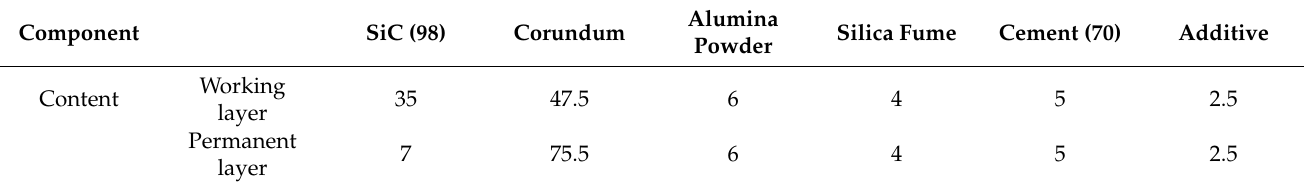
Table 2. Composition of the castable in the working layer of the trough